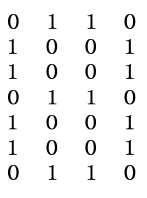
Fig. 3 Binary image matrix of “8”